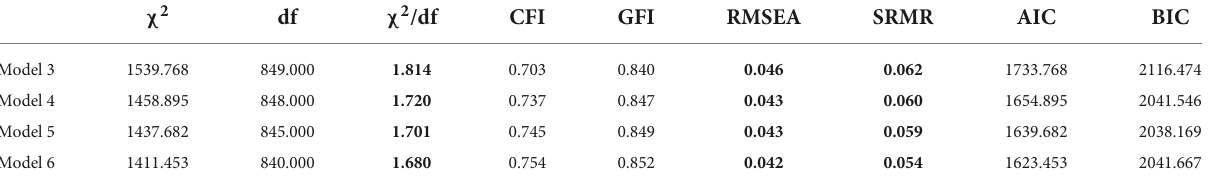
TABLE 3 Goodness-of-fit indices for the hypothesized latent factor RBS-R models ( N = 381). χ 2